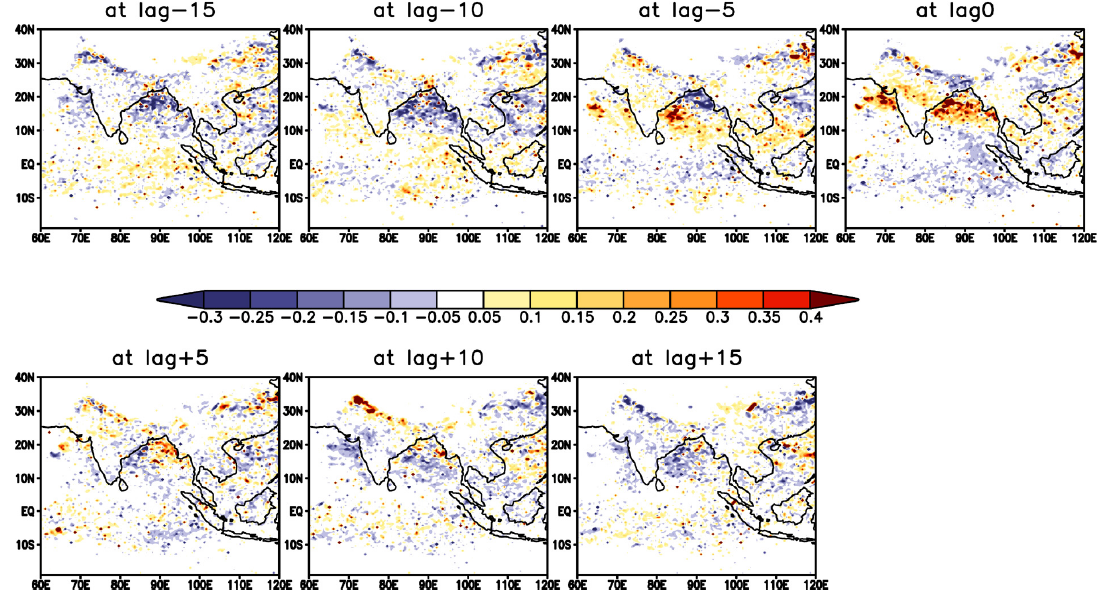
Fig. 14. Lag composite of convective rainfall (mmday − 1 ) during active spells based on TRMM 3G68